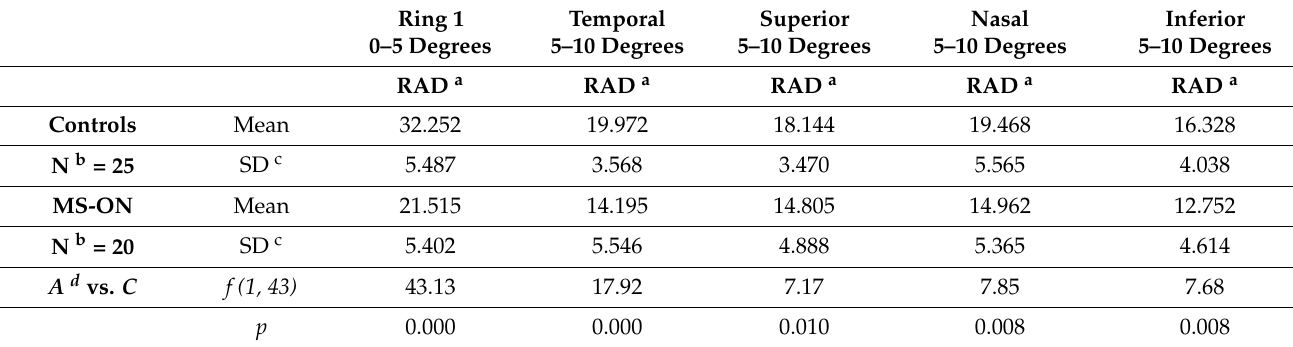
Figure 4. Multifocal photopic negative response (mfPhNR) ETDRS sector analysis. MfPhNR averaged are presented from a representative control eye (#7) and from an eye of a multiple sclerosis patient affected by optic neuritis (MS-ON) (#3). The mean mfPhNR response amplitude density (RAD) measure is indicated by an arrow ( ↕ ). We analyzed nine sectors covering an area of 20 ◦ of eccentricity from the fovea. The first sector (S1) corresponding to R1 (0–5 ◦ ) is reported on Figure 1; the more external sectors between 5 ◦ to 10 ◦ ( A ) and between 10 ◦ to 20 ◦ ( C ) were quarters of annulus, localized in the temporal (T), superior (S), nasal (N), and inferior (I) areas with respect to the fovea. Mean values of mfPhNR RAD (expressed in nanoVolt/degrees 2 , nV/deg 2 ) are plotted as a function of sector analysis on 5 ◦ to 10 ◦ ( B ) and between 10 ◦ to 20 ◦ ( D ). Vertical bars represent one standard deviation of the mean values. Dashed lines indicate the linear fitting for mfPhNR RADs (5 ◦ –10 ◦ : controls: r 2 = 0.58, MS-ON: r 2 = 0.28; 10 ◦ –20 ◦ : Controls: r 2 = 0.59, MS-ON: r 2 = 0.91). The relative functions show almost constant values of mfPhNR RADs in both controls and MS-ON eyes between sectors. * indicates the statistically significant ( p < 0.01) difference between MS-ON and control groups. The values of the statistical analysis are reported in Table 5. Table 5. Mean values of multifocal photopic negative response (mfPhNR) sector analysis between 5 to 10 degrees and between 10 and 20 degrees observed in controls (C) compared to multiple sclerosis patients with optic neuritis (MS-ON)